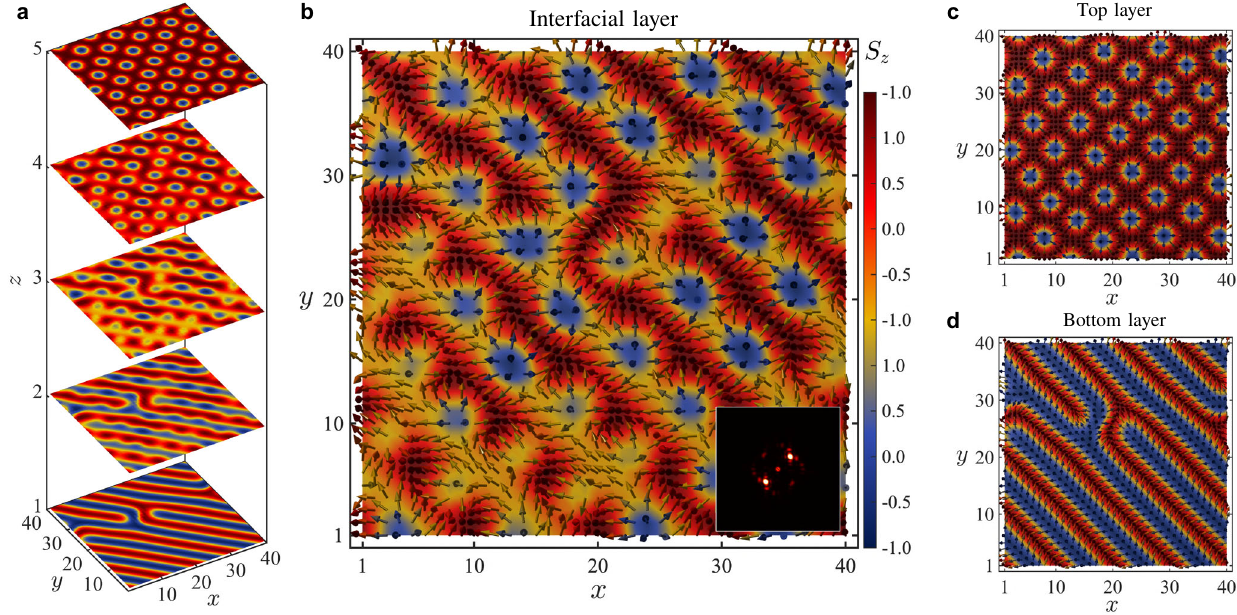
Fig. 3 Incommensurate skyrmion stripe. a Plot of the z -component of the spin S z , obtained via MC annealing, in a fi ve-layer heterostructure. b Spin con fi guration of the IPF frustration-stabilized incommensurate skyrmion stripe (ISkS), obtained via MC annealing at the central layer ( z = 3). c and d are the spin con fi gurations of a skyrmion crystal and a spin spiral at the top layer ( z = 5) and the bottom layer ( z = 1), respectively. The inset in b shows the central-layer spin structure factor S ( q ) within the fi rst Brillouin zone, revealing a multi- q magnetic order. The parameters used are D = 1.5 J , A z = 0.3 J , J = 1 (top layer), and D = J , A z = 0, J = 1 (bottom layer).